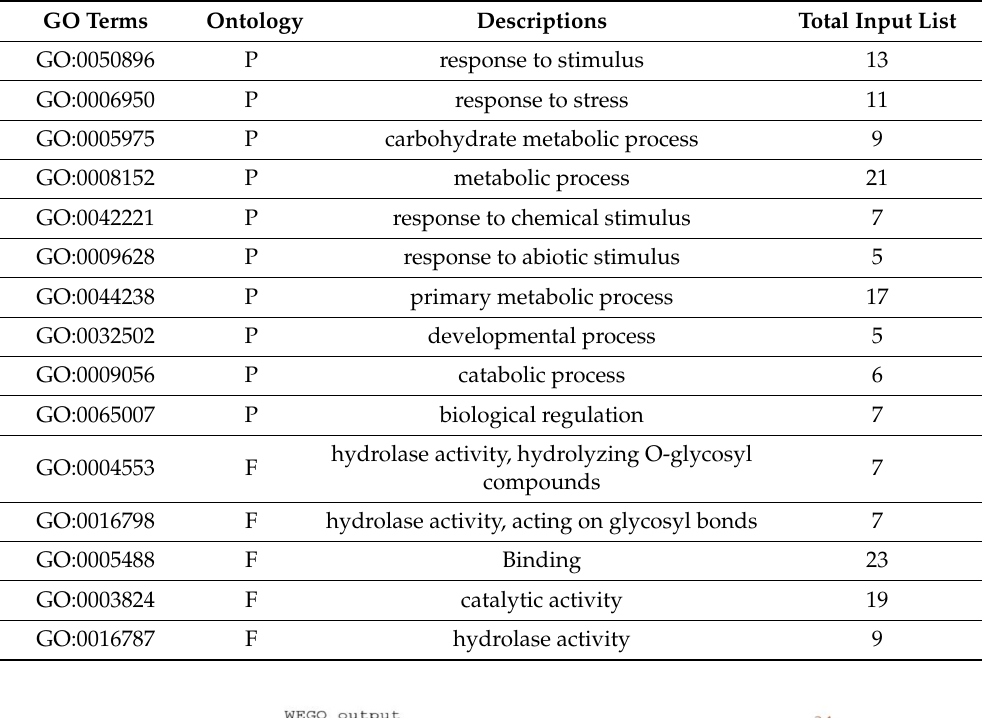
Table 2. Gene ontology descriptions of significantly upregulated genes.